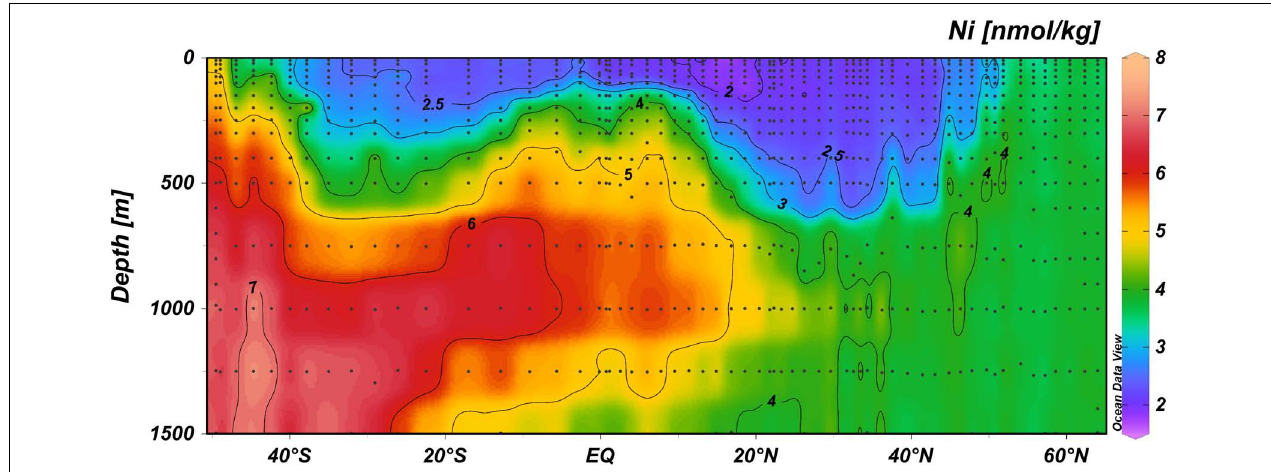
FIGURE 2 | The distribution of the concentration of Ni (nmol/kg) at expanded depth scale in the upper 1500 m depth range, along the GA02 section in non-linear color scale to best visualize the concentration gradients (auto adjust function of ODV).